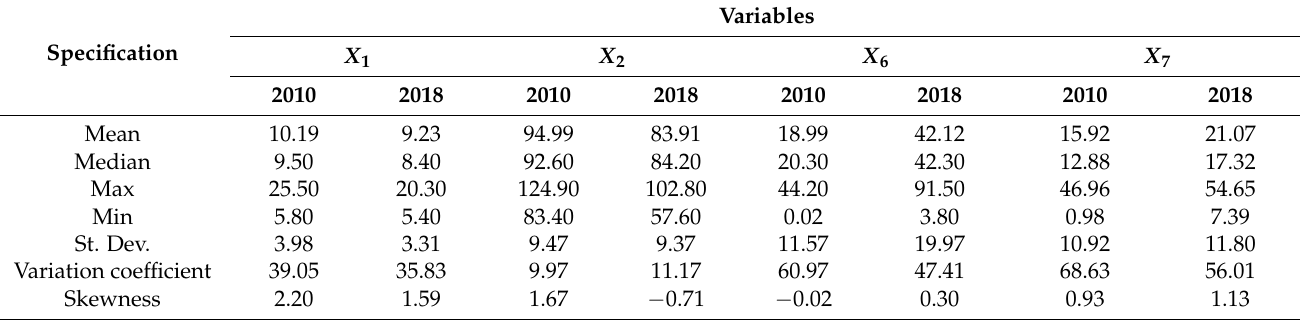
Table 3. Values of descriptive parameters in 2010 and 2018 regarding indicators defined in SDG13.